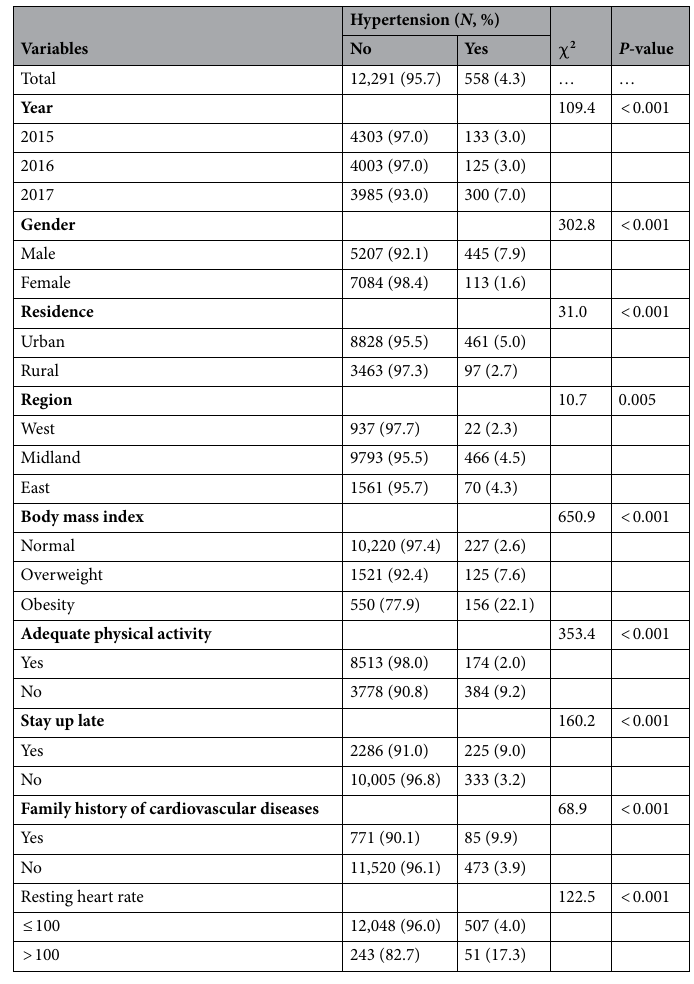
Table 3. The association between hypertension and socio-demographic characteristics of college